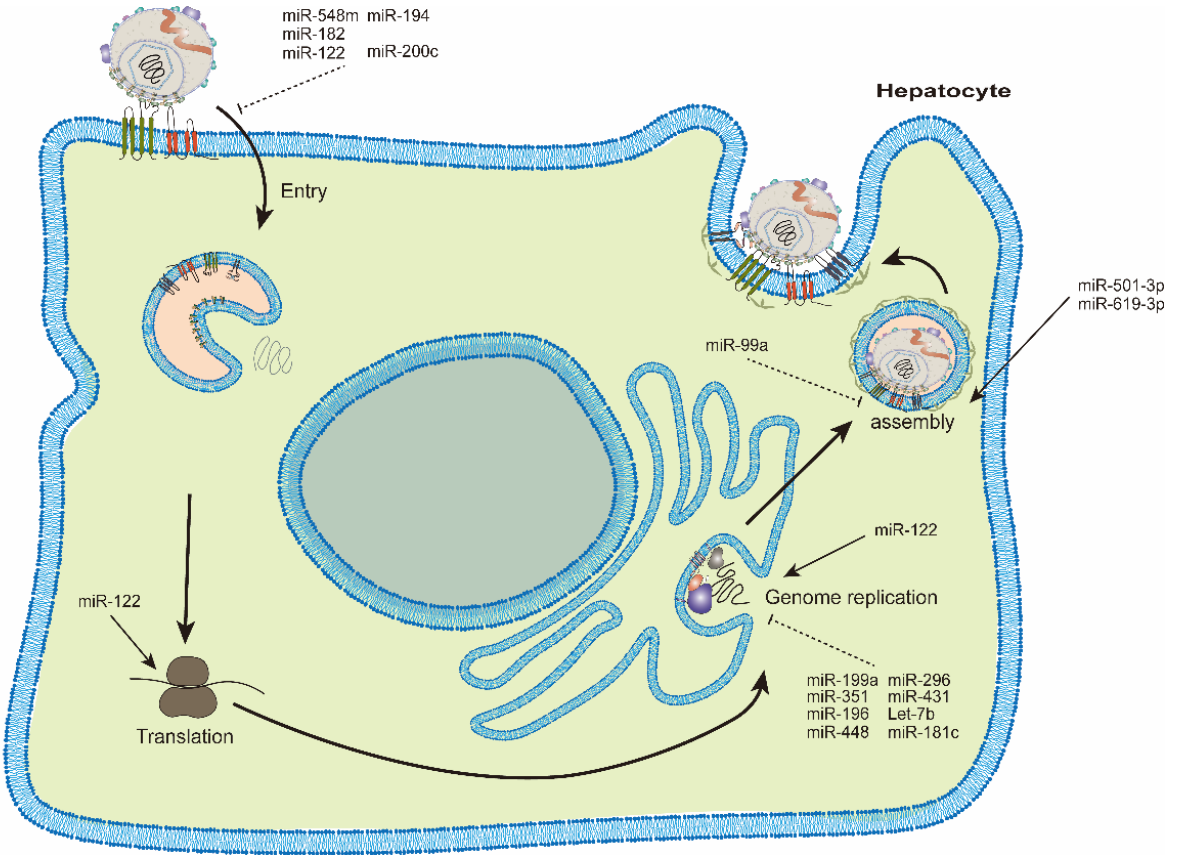
Figure 1. Various microRNAs modulate hepatitis C virus replication in different stages of viral lifecycle. Several miRNAs suppress HCV entry, such as miR-548m, miR-194, miR-182, miR-122 and miR-200c. Several miRNAs such as miR-196, miR-296, miR-351, miR-431, miR-448, miR-199a, let-7b and miR-181c suppress while miR-122 facilitates HCV genome replication. MiR-99a sup- presses while miR-501-3p and miR-619-3p facilitate HCV assembly. Table 1. miRNAs involved in different stages of HCV life